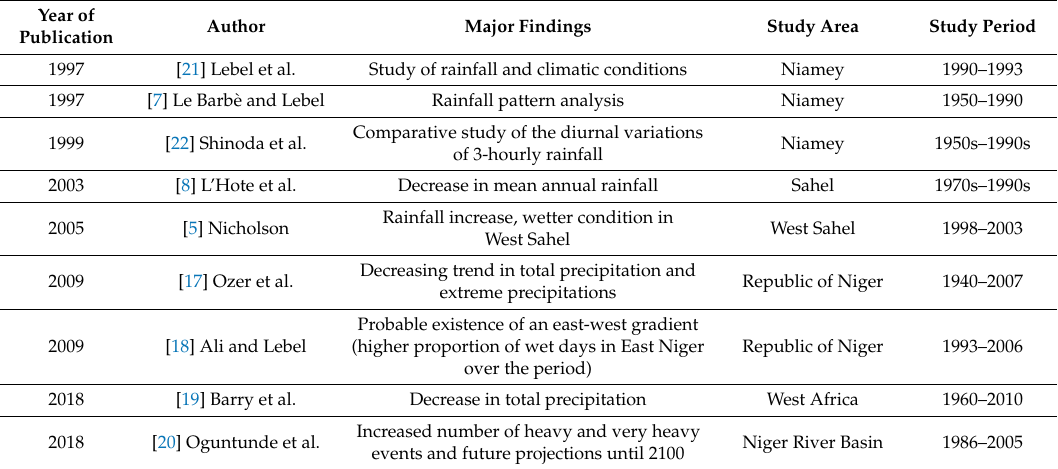
Table 1. Major findings attributable to the study